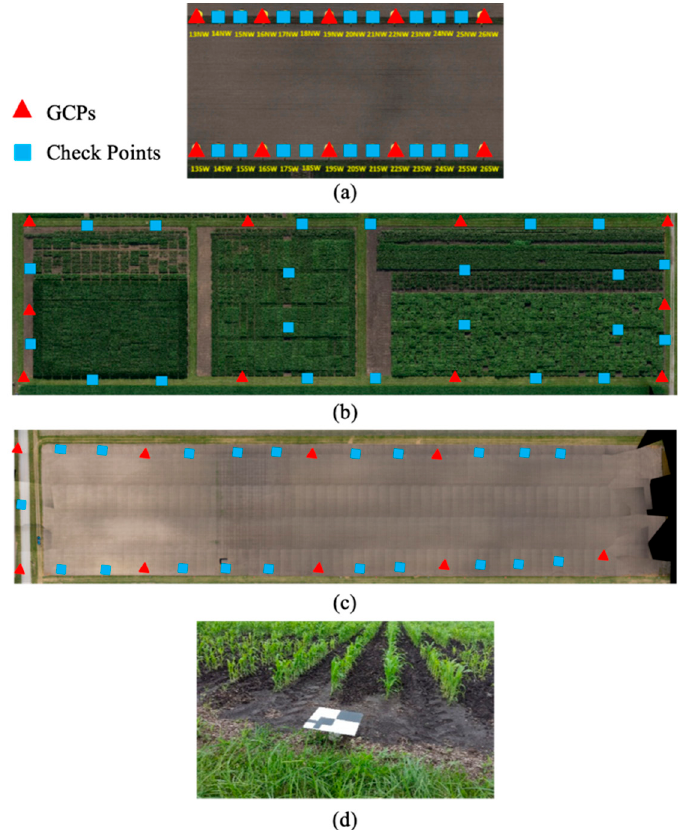
Figure 13. Configuration of the ground control points (GCPs) and check points in ( a ) Phantom2-Agriculture, ( b ) S1000-Agriculture-1, and ( c ) S1000-Agriculture-2 Datasets, and ( d ) a sample image of the targets established for both GCPs and check points in the test field. Table 3. The number of utilized GCPs and check points, the derived σ o , and the root-mean-square